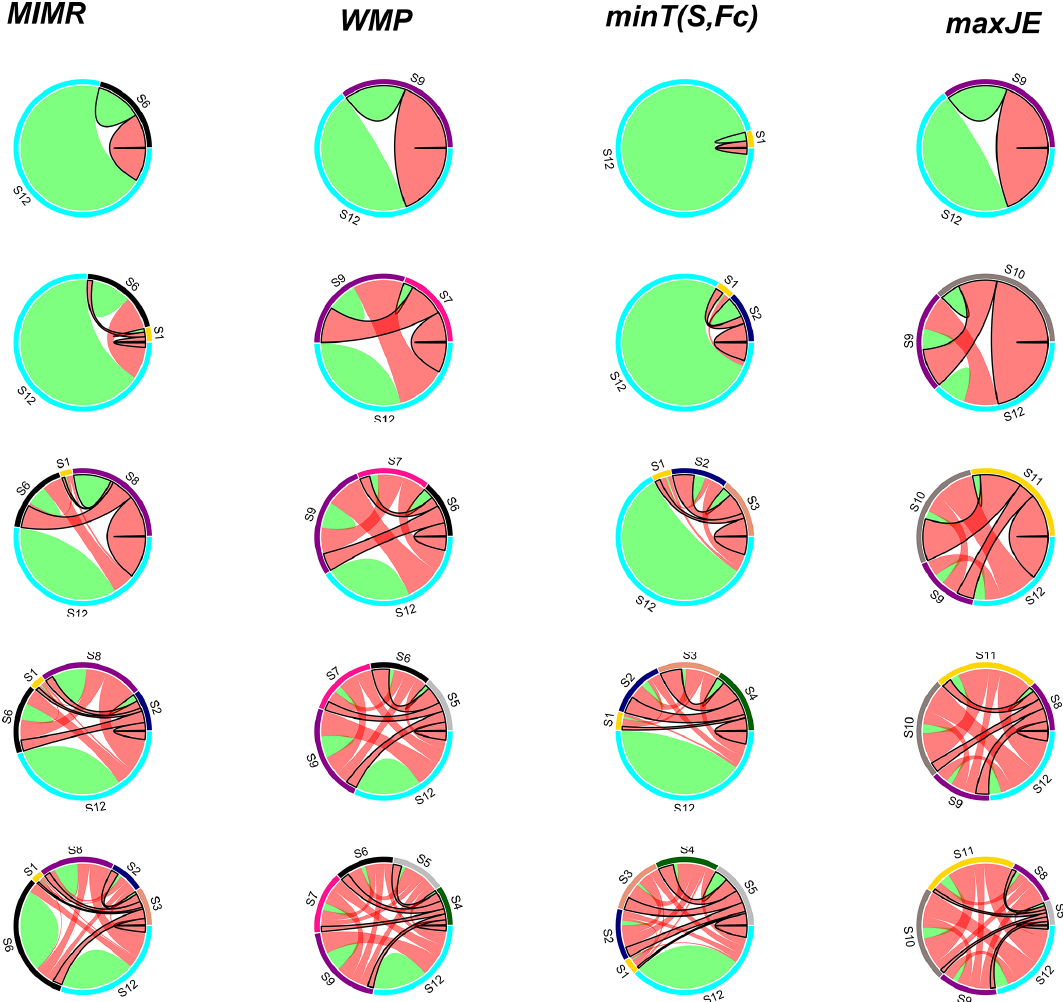
Figure 7. Evolution of pairwise information interaction between already selected stations in the previous iterations and new proposed station. Green and red links represent proportional conditional entropy and mutual information, respectively. Links with black border emphasize the information interactions with the new proposed station in each